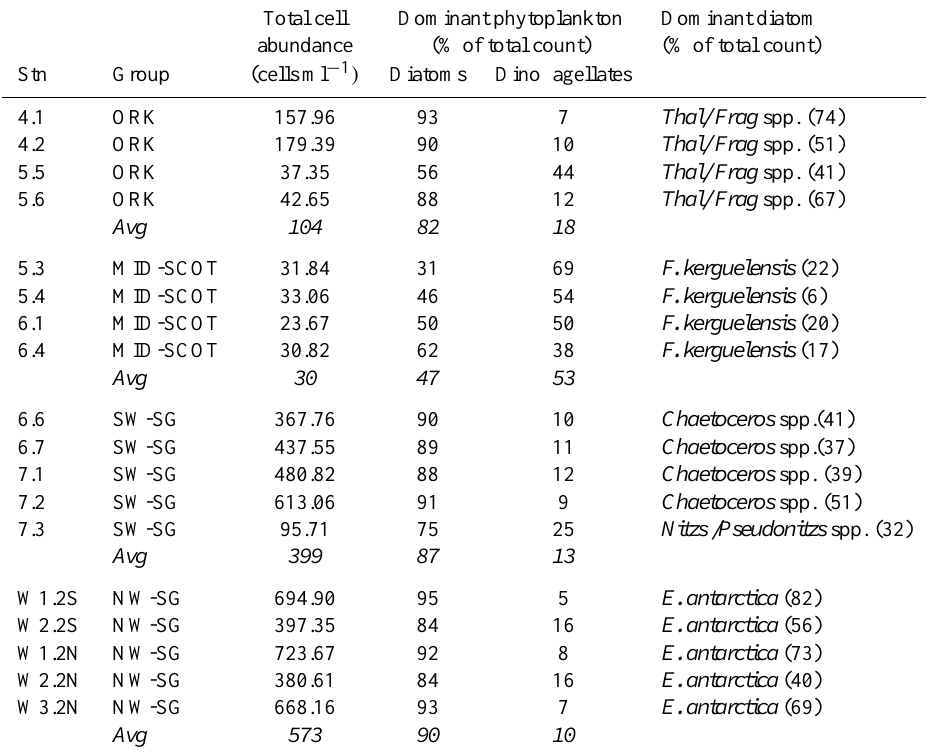
Table 2. Community composition of the 2003 summer stations (cell abundance). Thal/Frag – Thalassionema/Fragilariopsis spp., Nitzs/Pseudonitzs spp. – Nitzschia/Pseudonitzschia